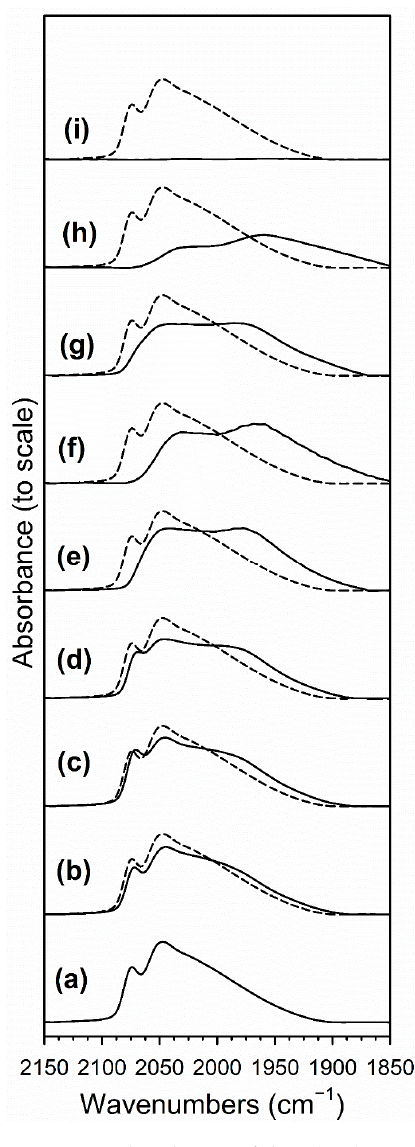
Figure 14. Absorbance of the ν (CO) on Pt surface band region (to scale), including ( a and dashed line spectra) 2%Pt/ZrO 2 , and the same catalyst doped with ( b ) 0.55%Rb, ( c ) 0.93%Rb, ( d ) 1.86%Rb, ( e ) 2.79%Rb, ( f ) 3.72%Rb, ( g ) 4.65%Rb, ( h ) 5.58%Rb, and ( i ) 9.29%Rb.